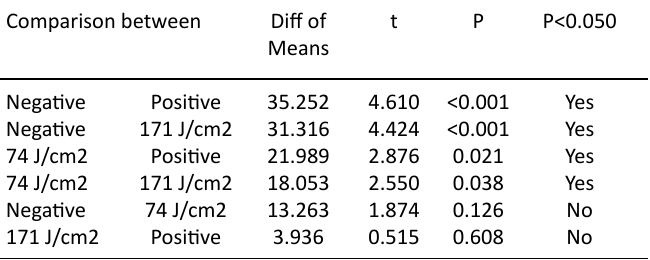
Table 6. Comparison of weight changes in day seven Comparison between